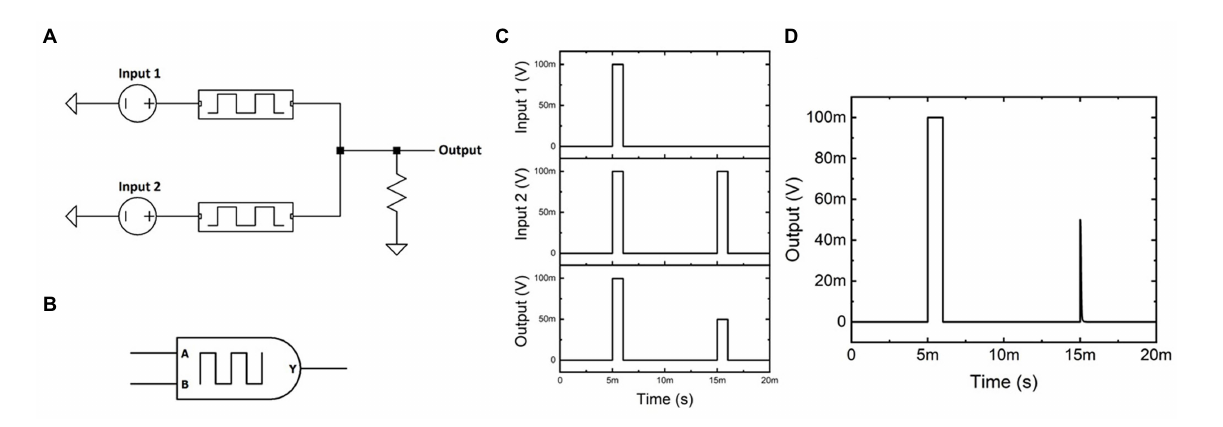
FIGURE 2 (A) Circuit schematic for VALVeD inputs using volatile memristors. (B) Circuit symbol for VALVeD inputs. (C) Transients of Input 1, Input 2, and the resulting Output when the volatile memristors are replaced with fixed resistors, resulting in a half-amplitude output for dissimilar inputs due to voltage division. (D) Transients of the Output using VALVeD inputs showing a heavily suppressed output for dissimilar inputs, thereby behaving in the same way as a logic AND gate.